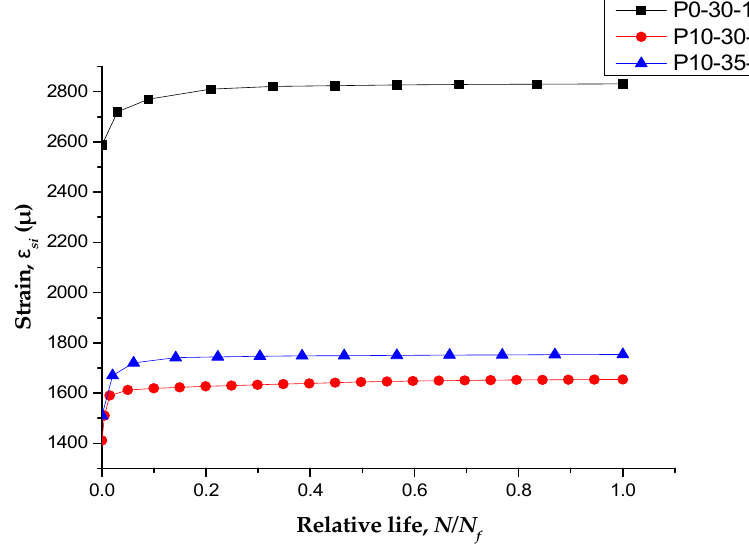
Figure 12. Strains of main steel bars at the peak loads.